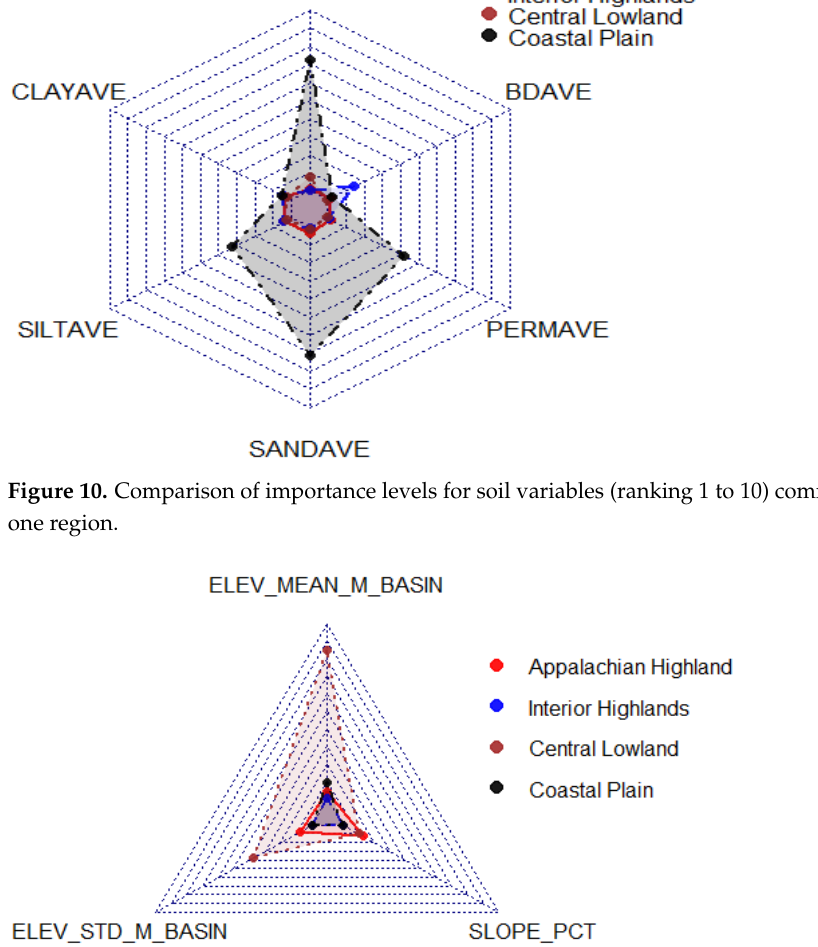
Figure 11. Comparison of importance levels for topography variables (ranking 1 to 10) common to more than one